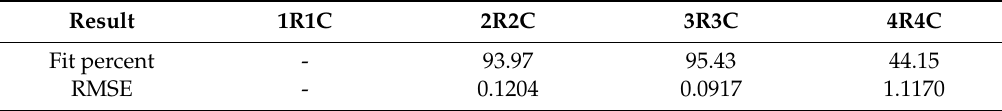
Table 7. Fifteen-minute prediction results for experiment B.